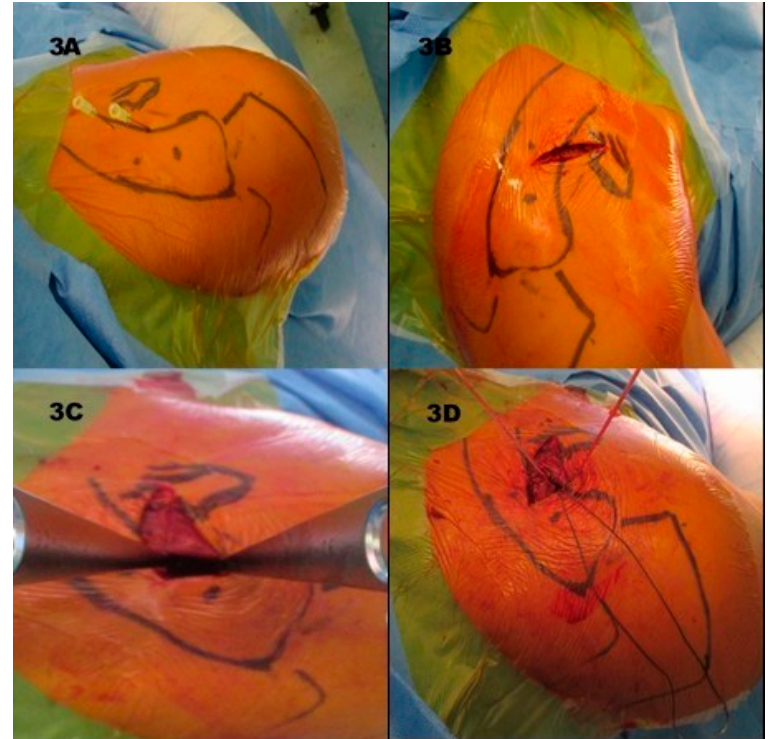
Figure 3. ( 3A ) Landmarks, dots representing drill holes at clavicle, needles coracoid base; ( 3B ) skin incision over coracoid base and ( 3C ) Hohmann hooks at the coracoid base; ( 3D ) acromioclavicular (AC) capsule sutures on the right sight, FiberWire sutures in cranial direction.